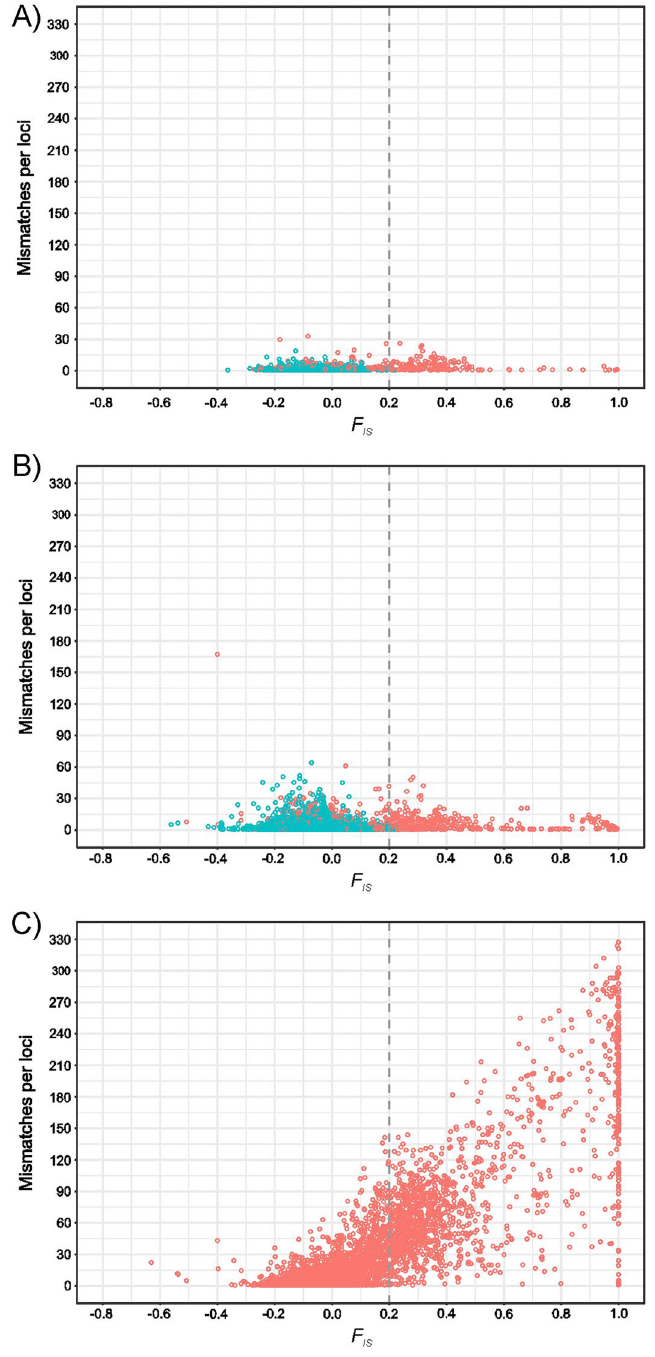
Figure 6. Number of allelic mismatches (on the Y-axis) per loci illustrated according to F IS value (on the X-axis) and classes of ME. Plots ( A ), ( B ) and ( C ) show the TrioA mismatches, the TrioB mismatches, and the sum of the mismatches assigned to the Father, Mother or Offspring error classes, respectively. Loci that have either TrioA or TrioB errors only are in blue whereas loci having errors assigned to a member of the trio (Father, Mother or Offspring) as well are in red. Vertical lines represent F IS threshold of